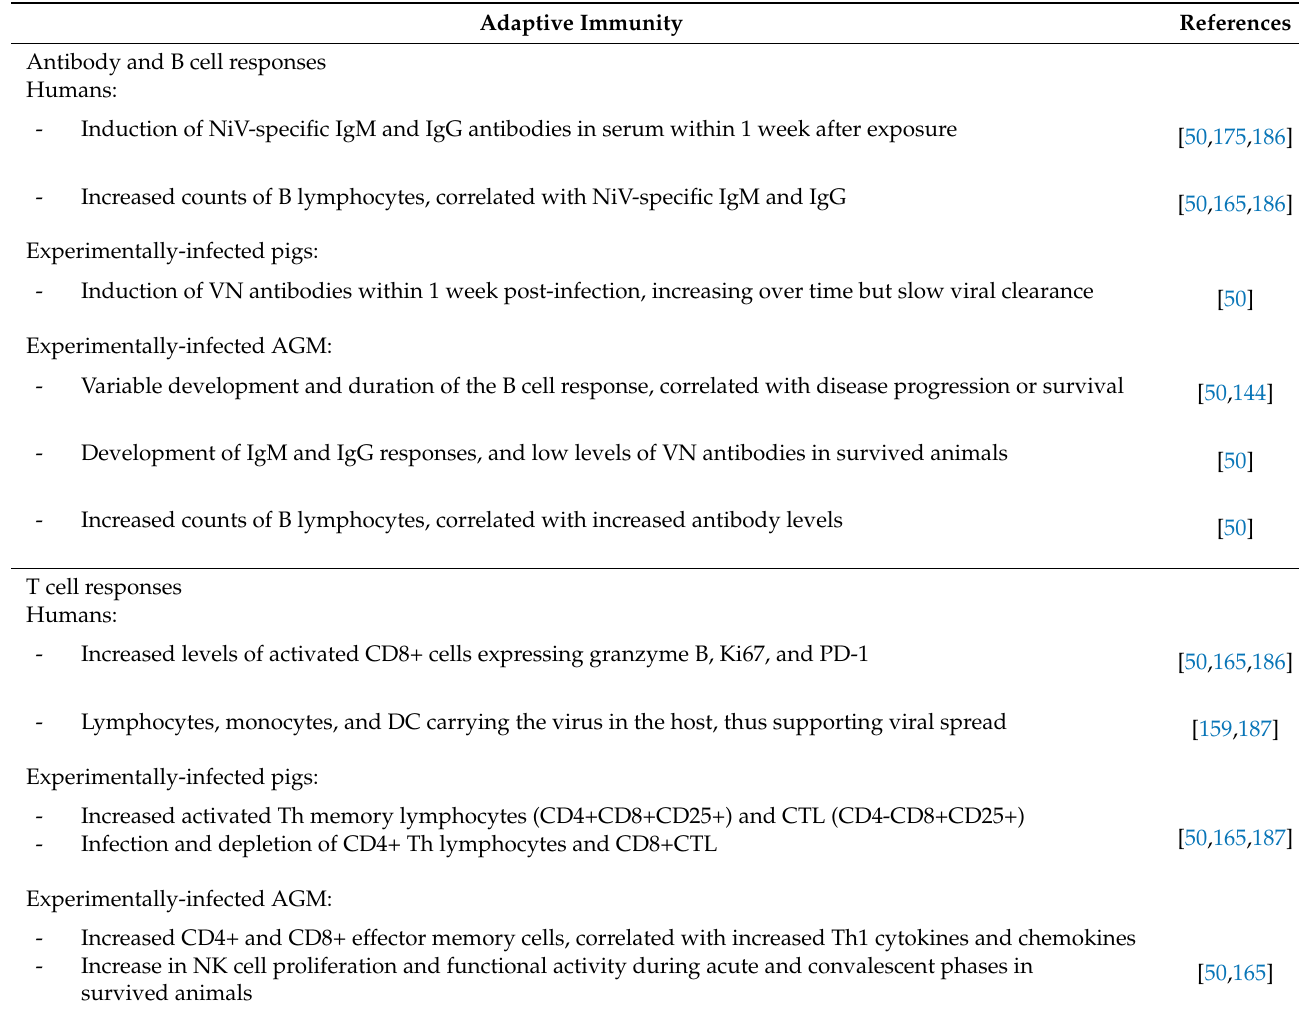
Table 3. Main adaptive immune responses and immune modulation upon NiV